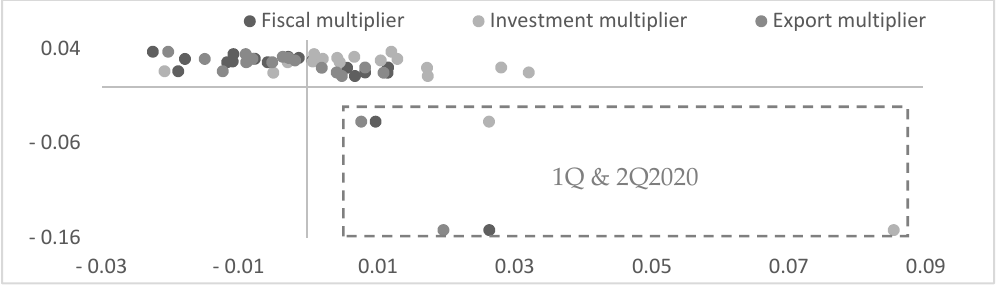
Figure 9. Correlation of changes in autonomous expenditure multipliers to GDP—France, own work, source: Eurostat.